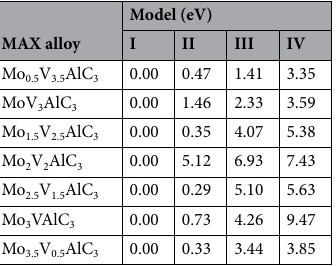
Table 1. Relative energy (in eV) for the first four most stable V x-1 Mo x AlC 3 MAX alloy models.